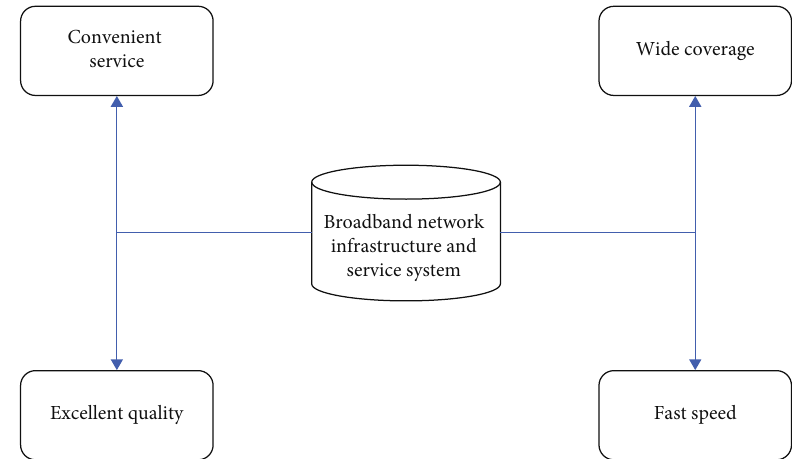
Figure 3: Characteristics of broadband network infrastructure and service